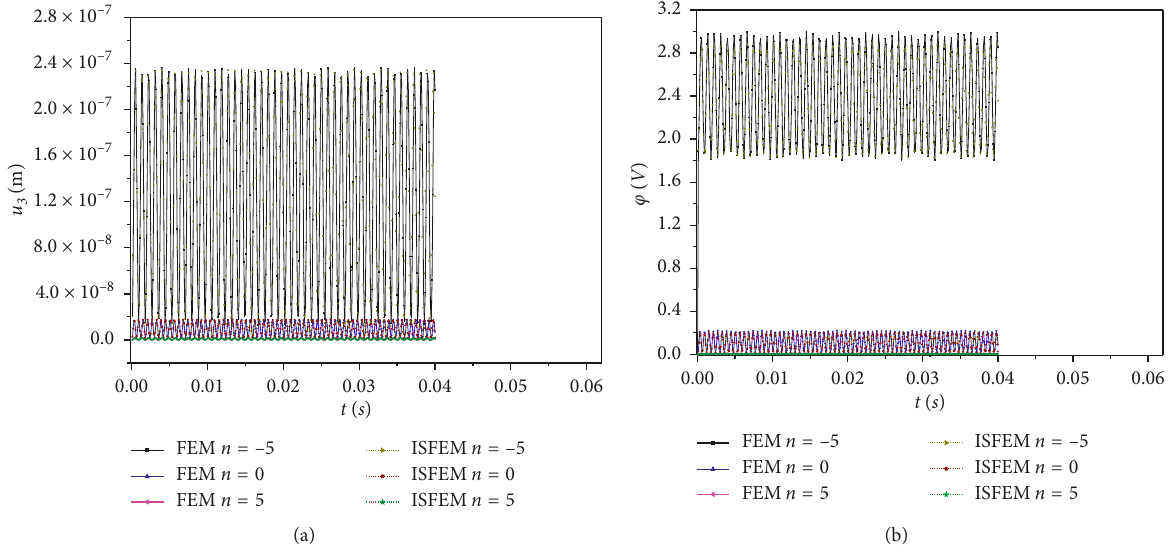
Figure 12: Variations of displacement u 3 and electrical potential φ at the loading point with time of the FGPM beam based on PZT-4 when the gradient parameter was n � − 5, 0 and 5 under step load. (a) Displacement. (b) Electrical potential.